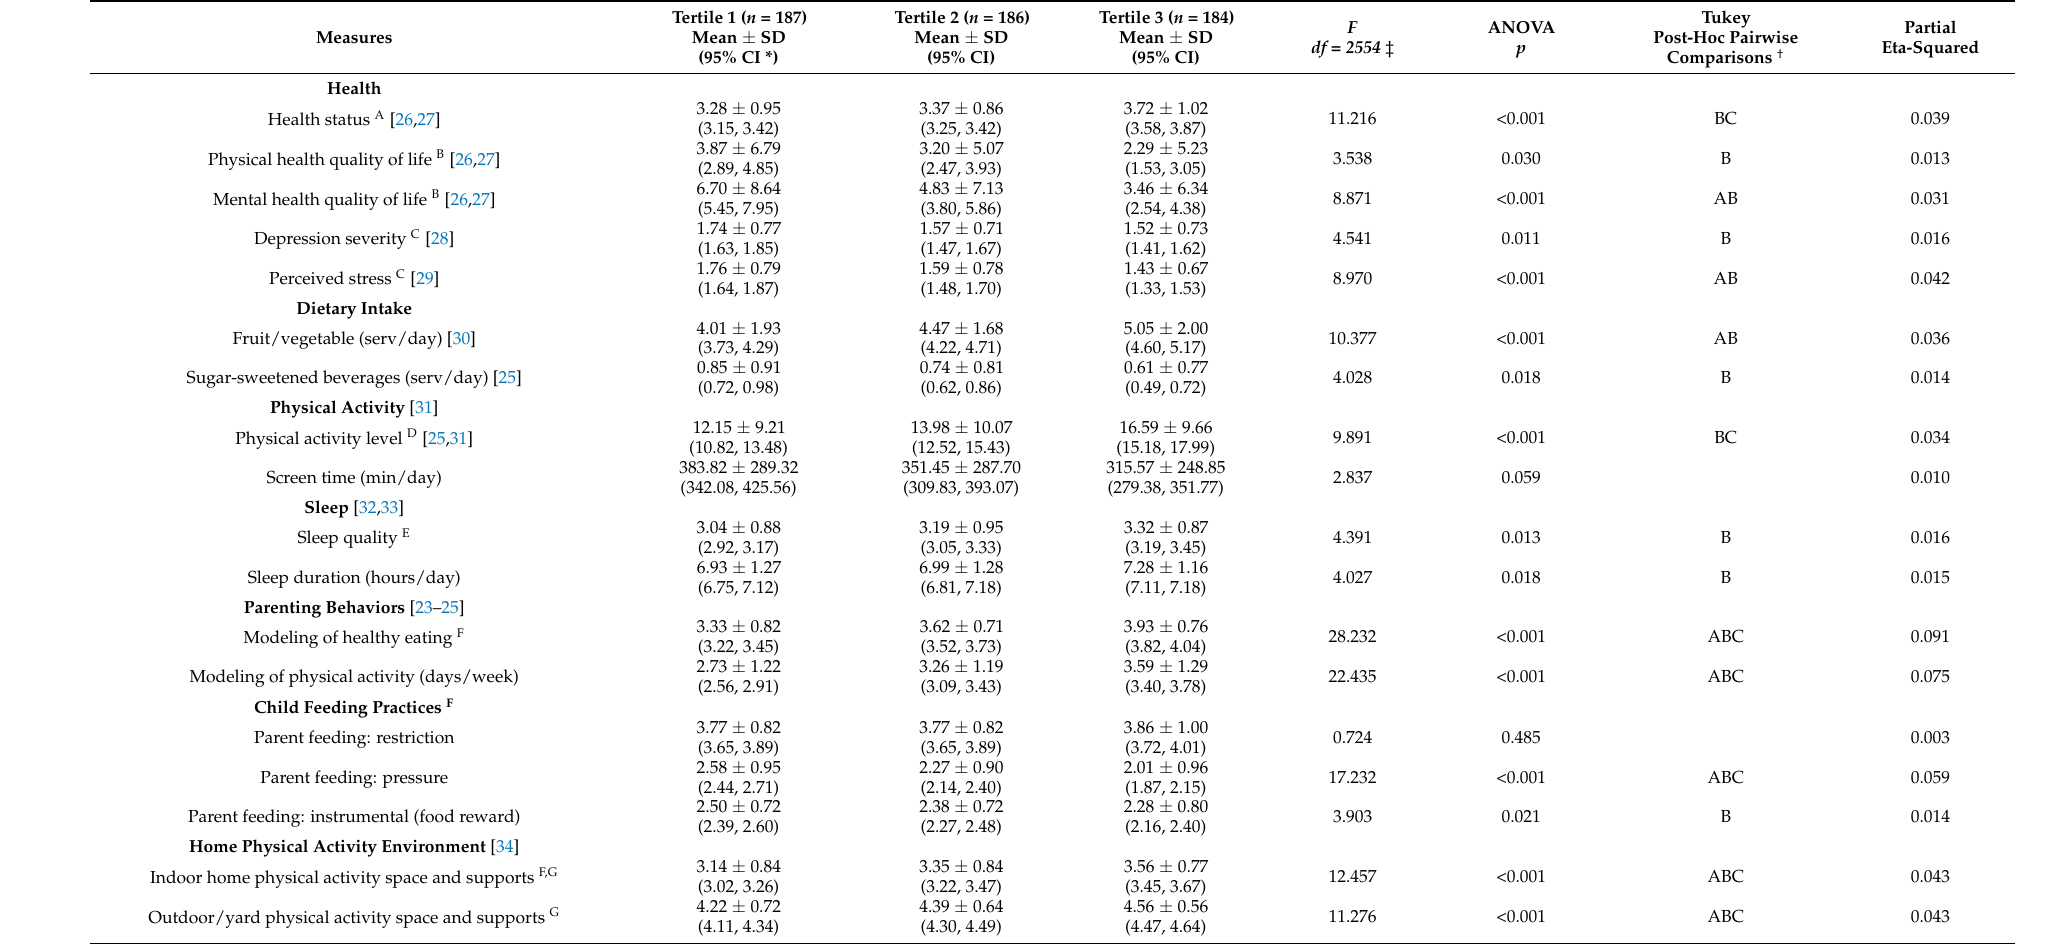
Table 3. Maternal health, weight-related behaviors, and home environment comparisons by family social capital tertiles ( n =